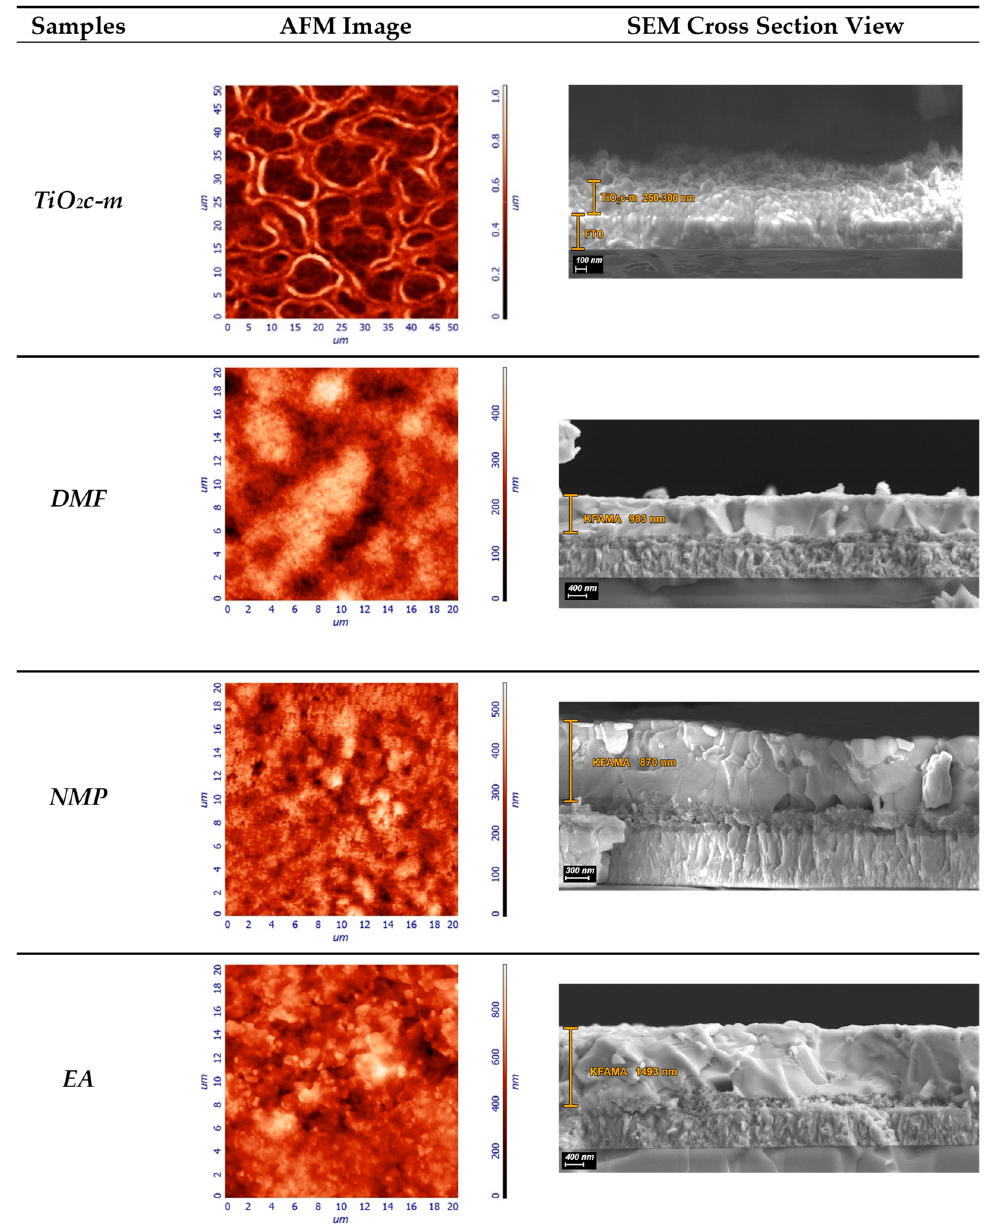
Figure 1. Surface AFM and cross-section SEM images for perovskite and ETL layers. The AFM images of the perovskite layers reveal consistent films. The rugosity varies